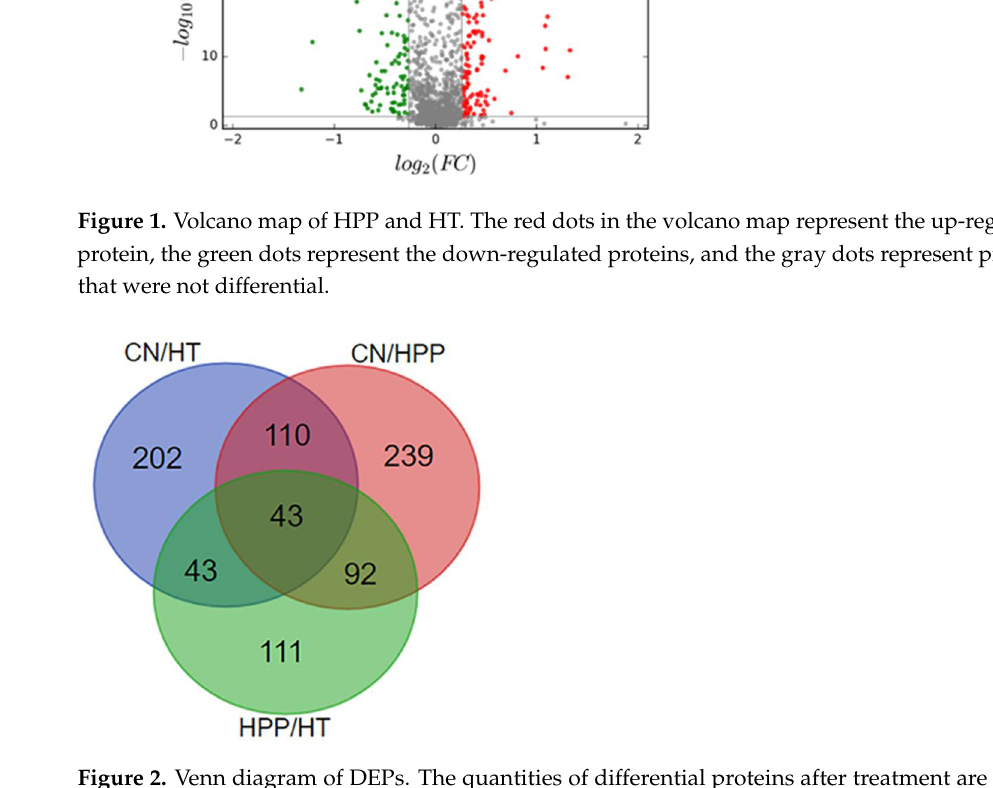
Figure 2. Venn diagram of DEPs. The quantities of differential proteins after treatment are clearly shown in Figure